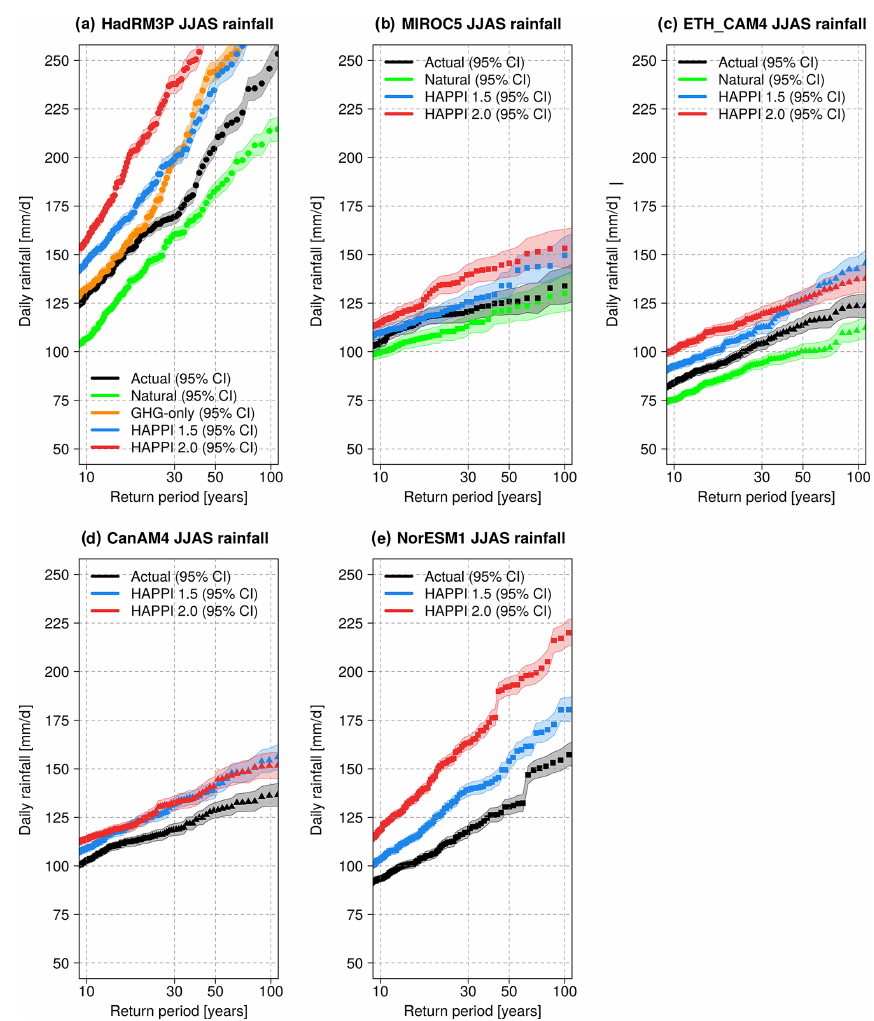
Figure 13. Comparative return periods (10–100-year events) of JJAS daily rainfall (md − 1 ) over sub-region 2 during 1986–2015 as per (a) HadRM3P, (b) MIROC5, (c) ETH_CAM4, (d) CanAM4, and (e) NorESM1 models. ACT, NAT, GHG-only, plus 1.5 and 2.0 ◦ C model ensembles are shown in black, green, orange, blue, and red colours,